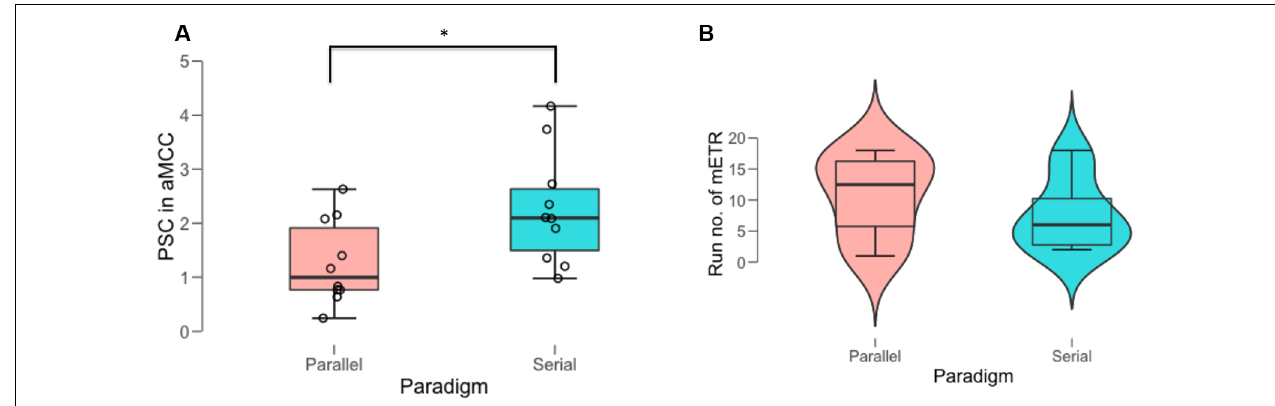
FIGURE 2 | Behavioral outcomes of the most efficient training run (mETR). (A) Percent signal change (PSC) in anterior midcingulate cortex (aMCC) achieved during the mETR in the two paradigms. (B) Distribution of the temporal position of the mETR (run no. of mETR) within the schedule of the 18 NF training runs in the two paradigms. ∗ Denotes significant difference at the threshold of p = 0.05.